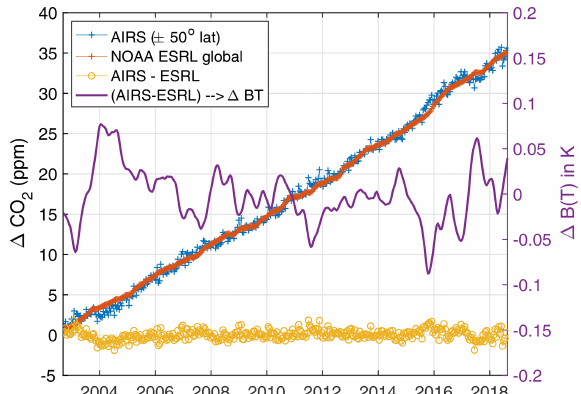
Figure 10. Retrieved CO 2 anomalies compared to ESRL global in situ data. The CO 2 anomaly difference between AIRS and ESRL is shown in yellow. The magenta curve is that difference converted into BT